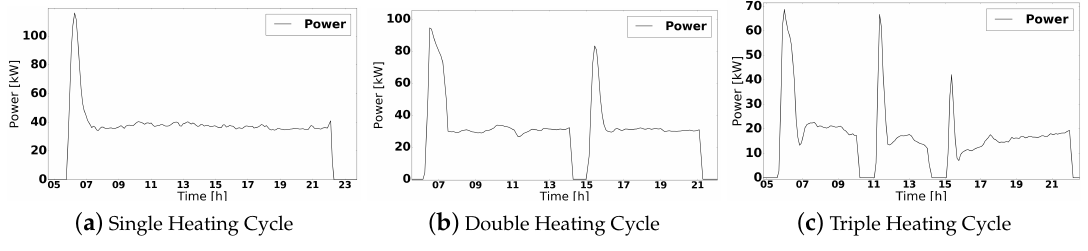
Figure 5. Heating cycles in a